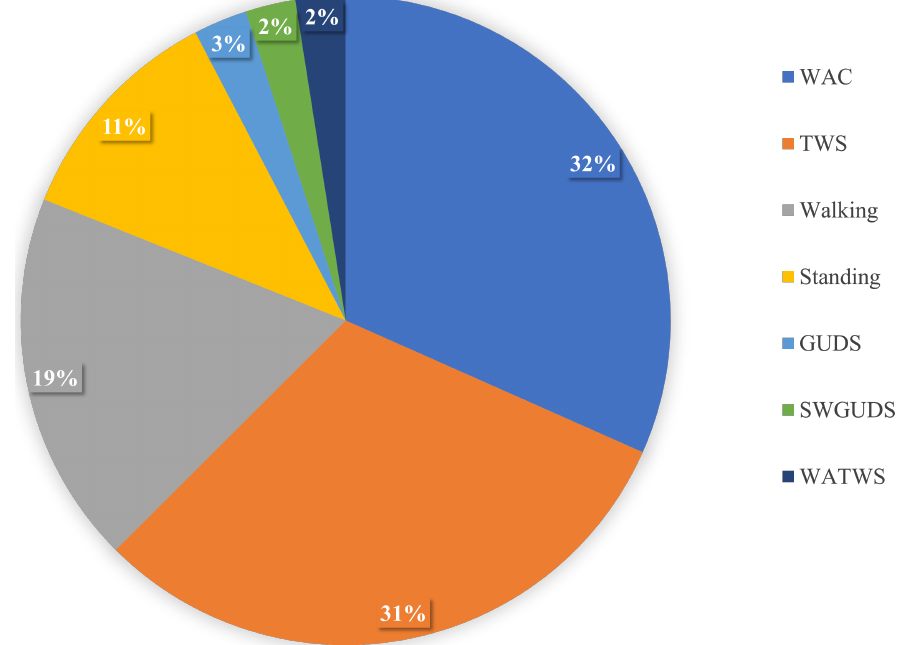
Figure 4. Activity distribution of the ADL